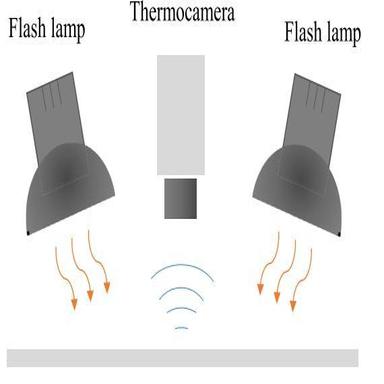
Sketch of a setup of optical pulsed thermography for inspection of composite laminates.